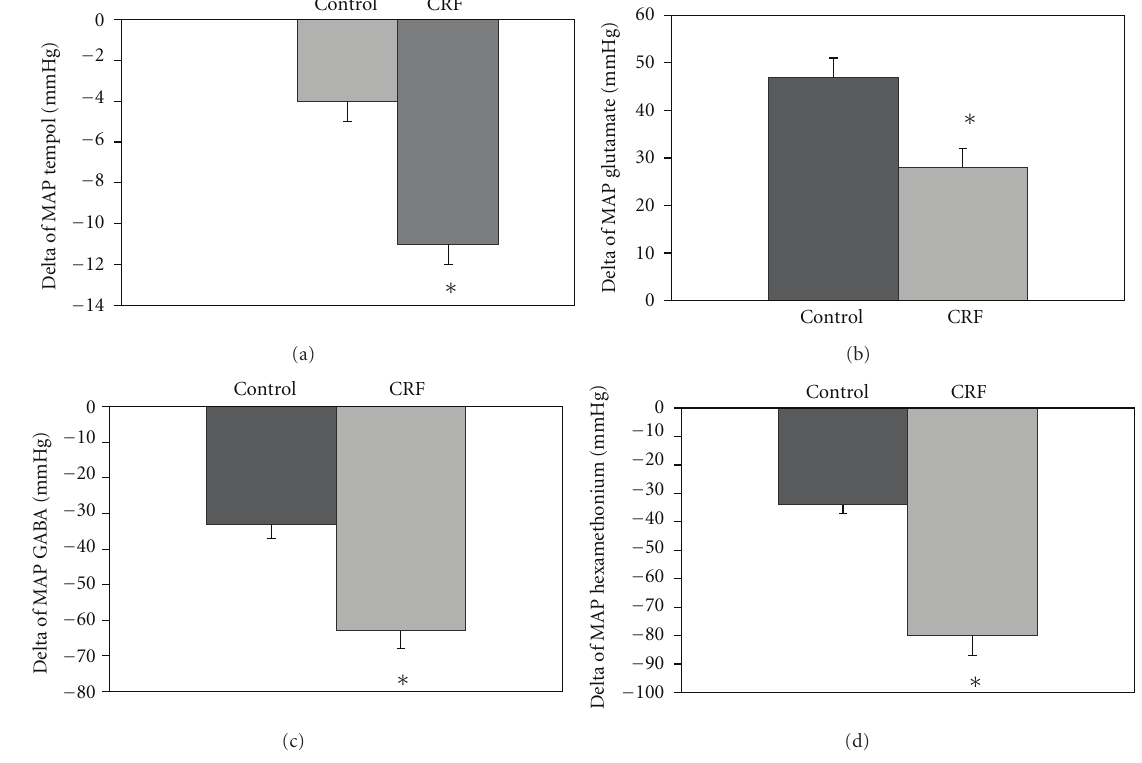
Figure 3: Values of delta of variation of mean arterial pressure (MAP) during bilateral microinjection of tempol (2.0nmol/100nL) (a), glutamate (10nmol/100nL) (b), GABA (50nmol/100nL) (c), hexamethonium (30mg/kg, IV) (d) into the RVL in the C and CRF groups. ∗ P < . 05 di ff erence in relation to the